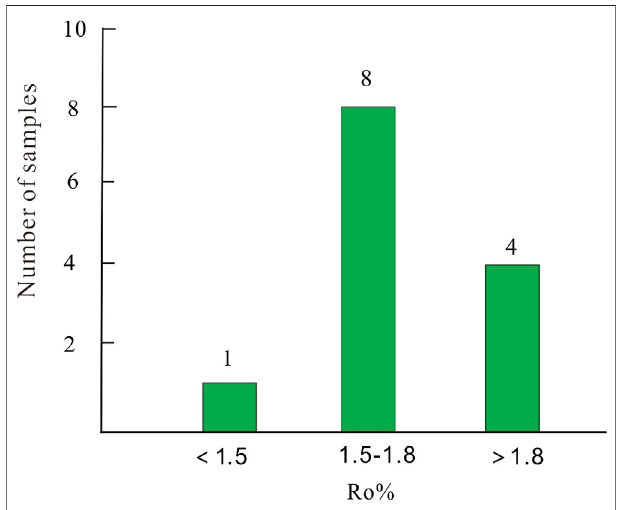
FIGURE 7 | Histogram of Ro distribution of source rock in XJC 1 Well.